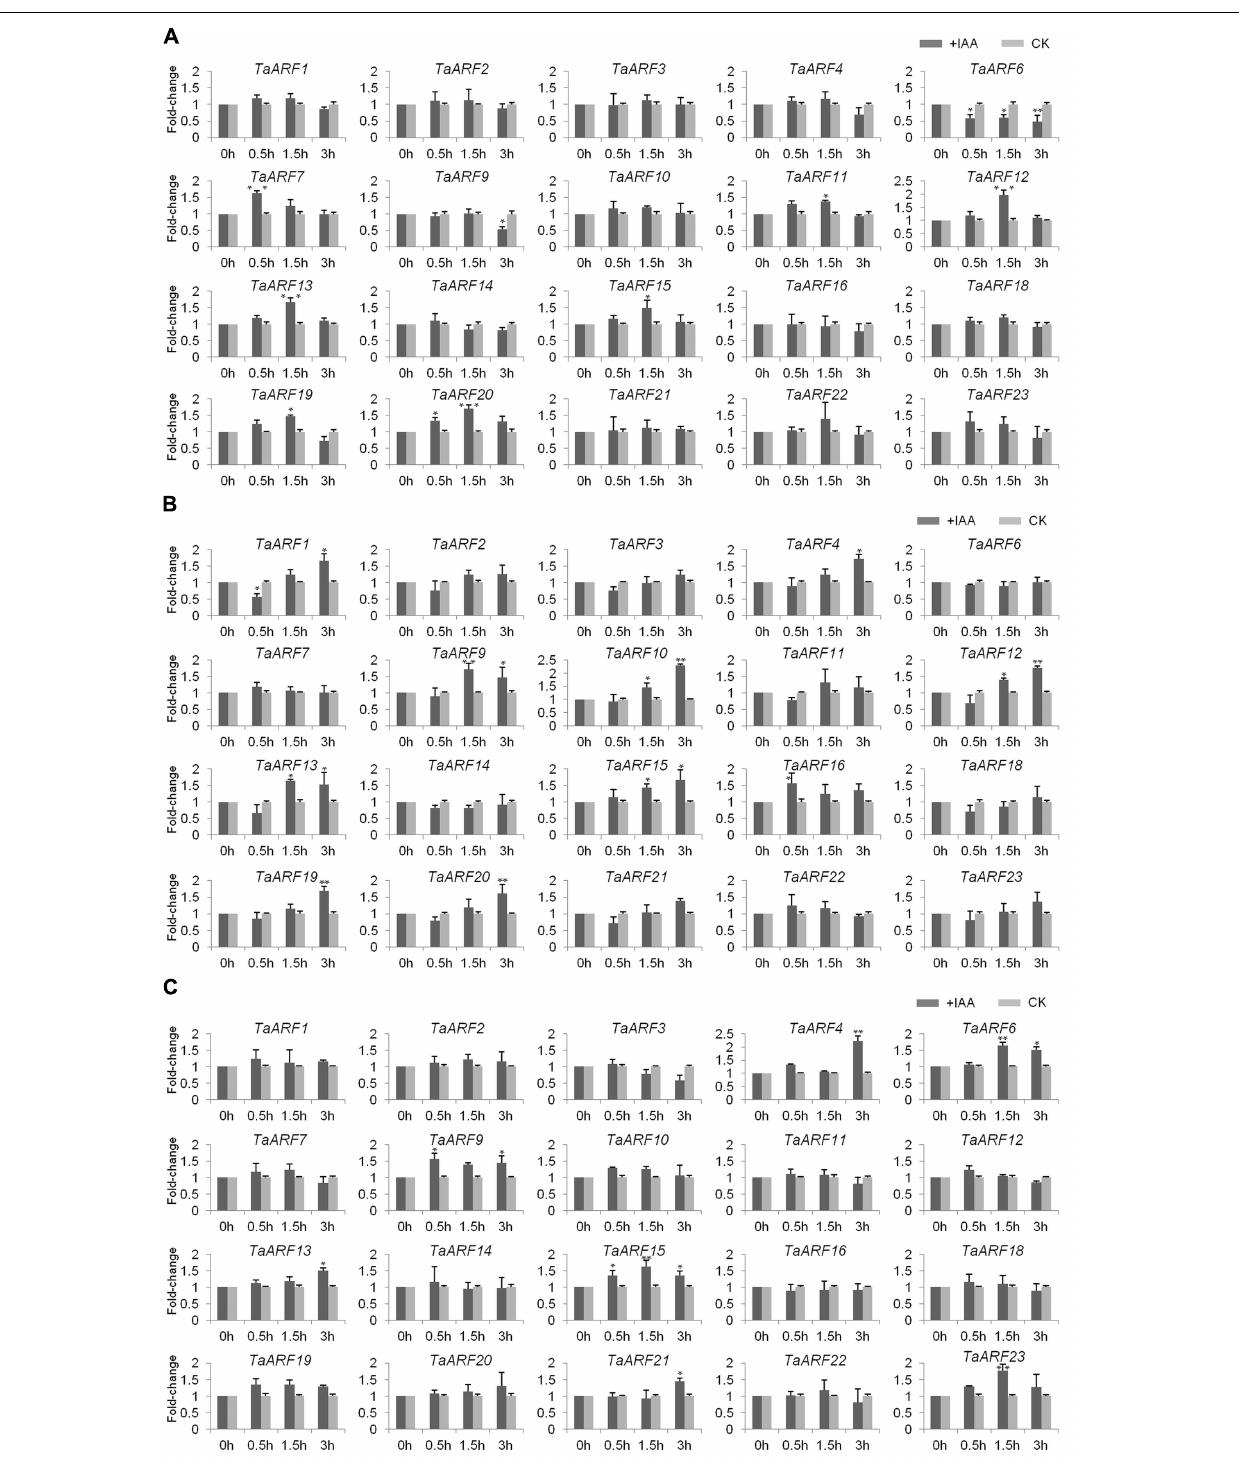
Frontiers in Plant Science |